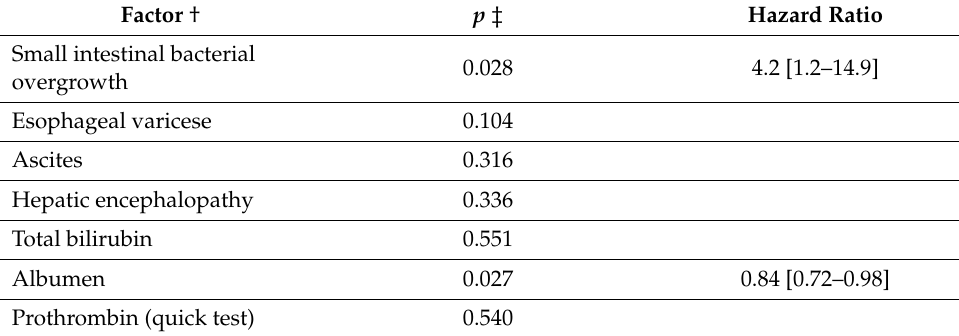
Table 3. Assessment of risk factors for death in our